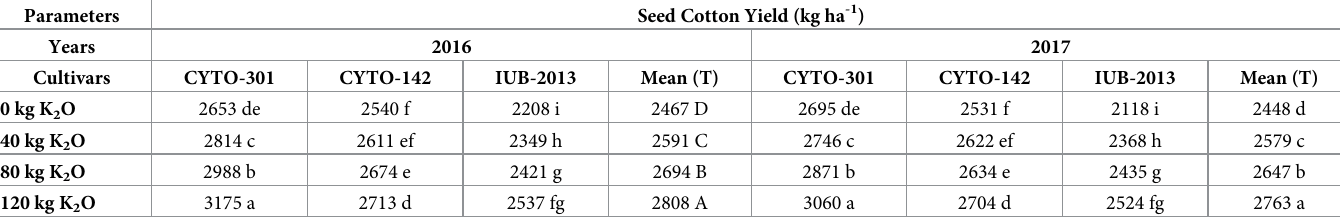
C = Cultivars, T = Treatments, NS = Non-significant, Different alphabets with in the same column or row indicate statistically significant